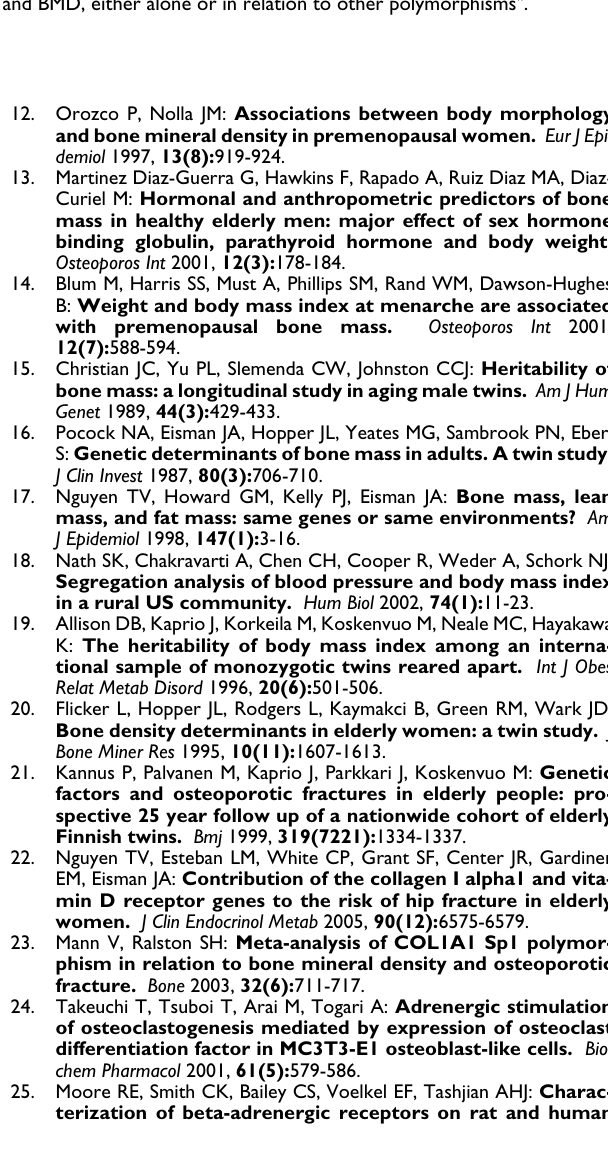
Lumbar spine BMD (mean; SD)